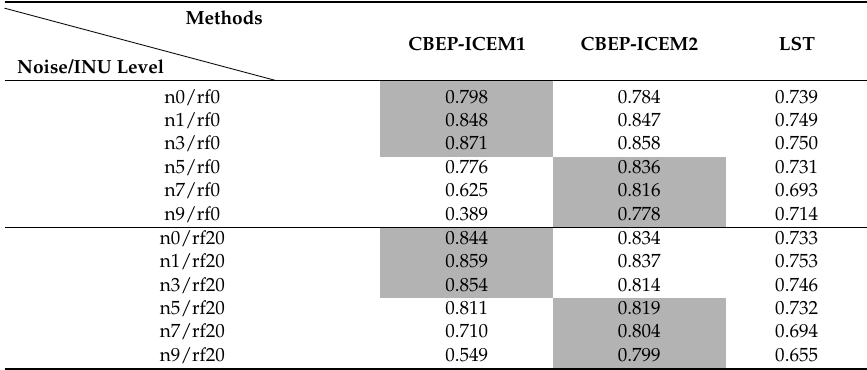
Table 3. Averaged DSI values of lesions detection by CBEP-ICEM1, CBEP-ICEM2 and LST over MR image slices 91–113 using slice 102 to select training